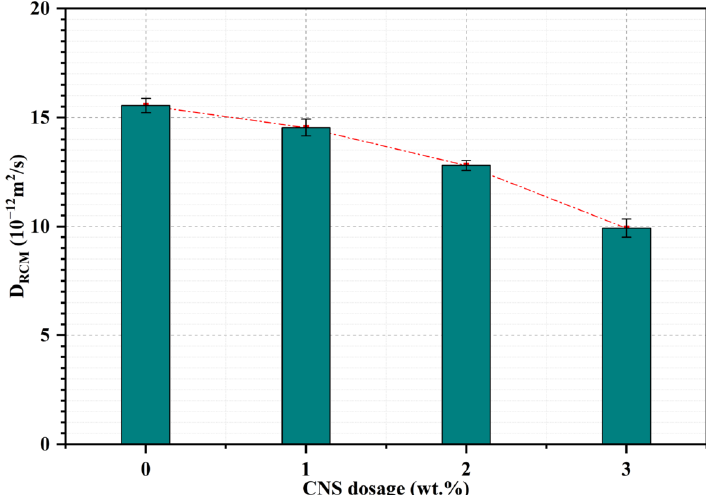
Figure 8. Chloride diffusion coefficient of mortars at 28 days.